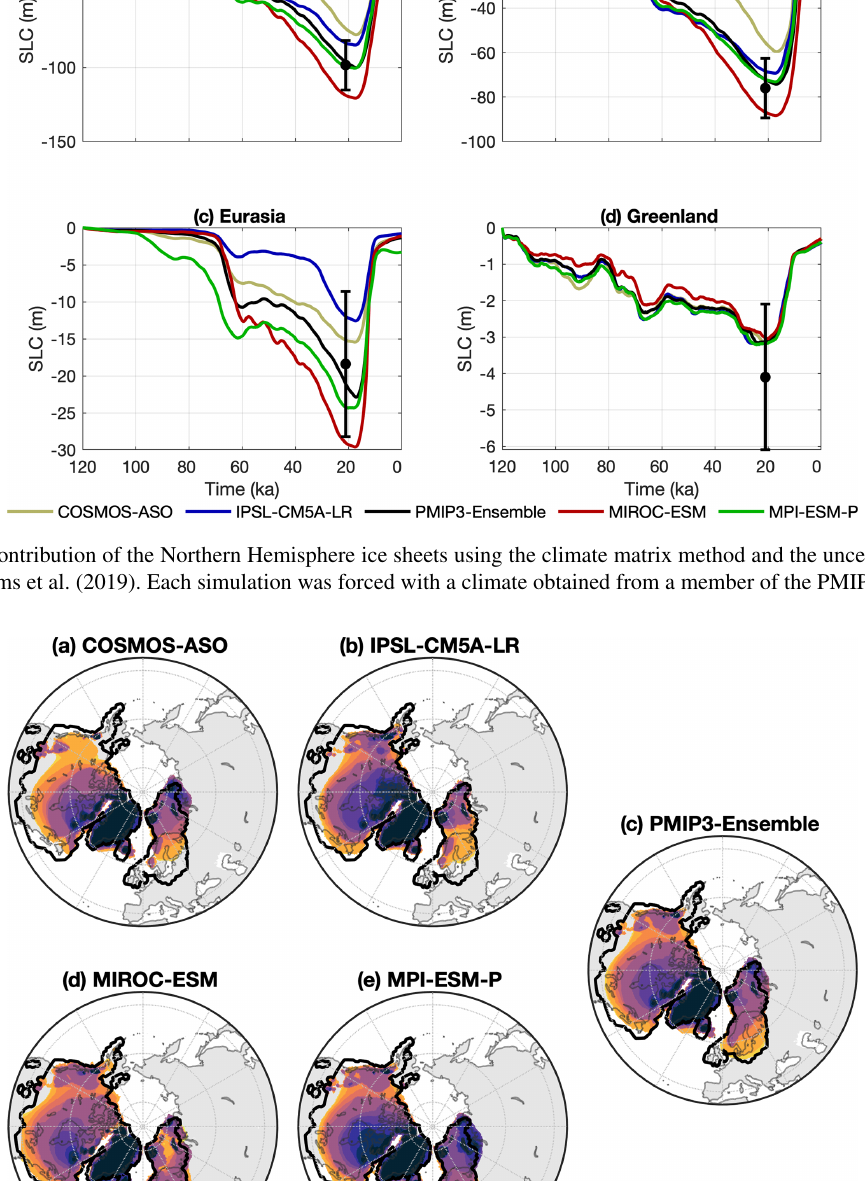
Clim. Past, 19, 399–418,